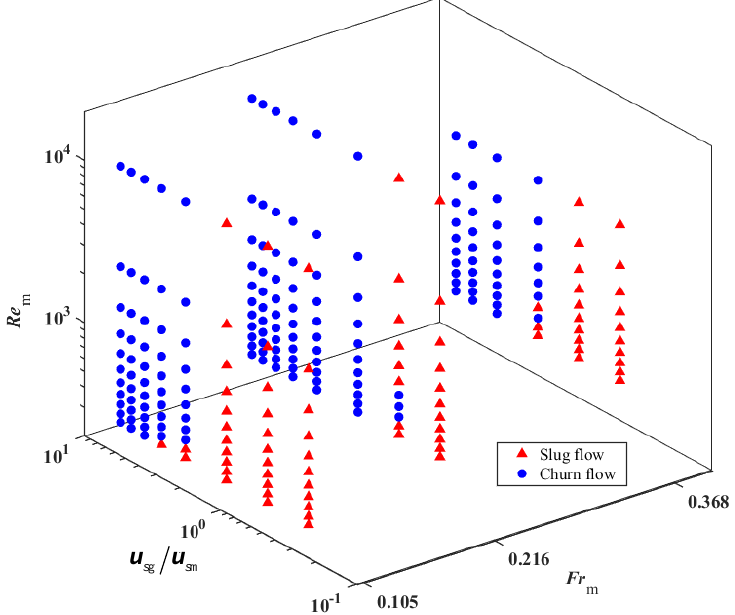
Figure 9. Flow pattern maps in the vertical section, in which the dimensionless number Re m ranged from 298 to 21,193, the dimensionless number u sg /u sm ranged from 0.25 to 6, and the dimensionless number Fr m was fixed at 0.105, 0.216, and 0.368.